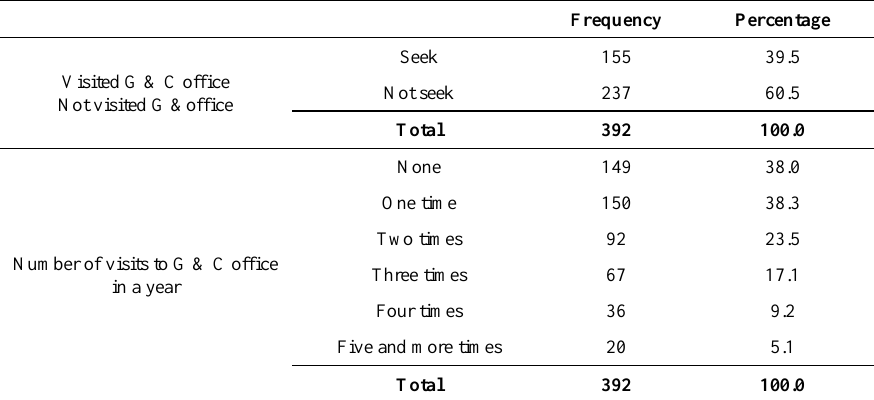
Table 2. Students visit frequency to guidance and counseling office.